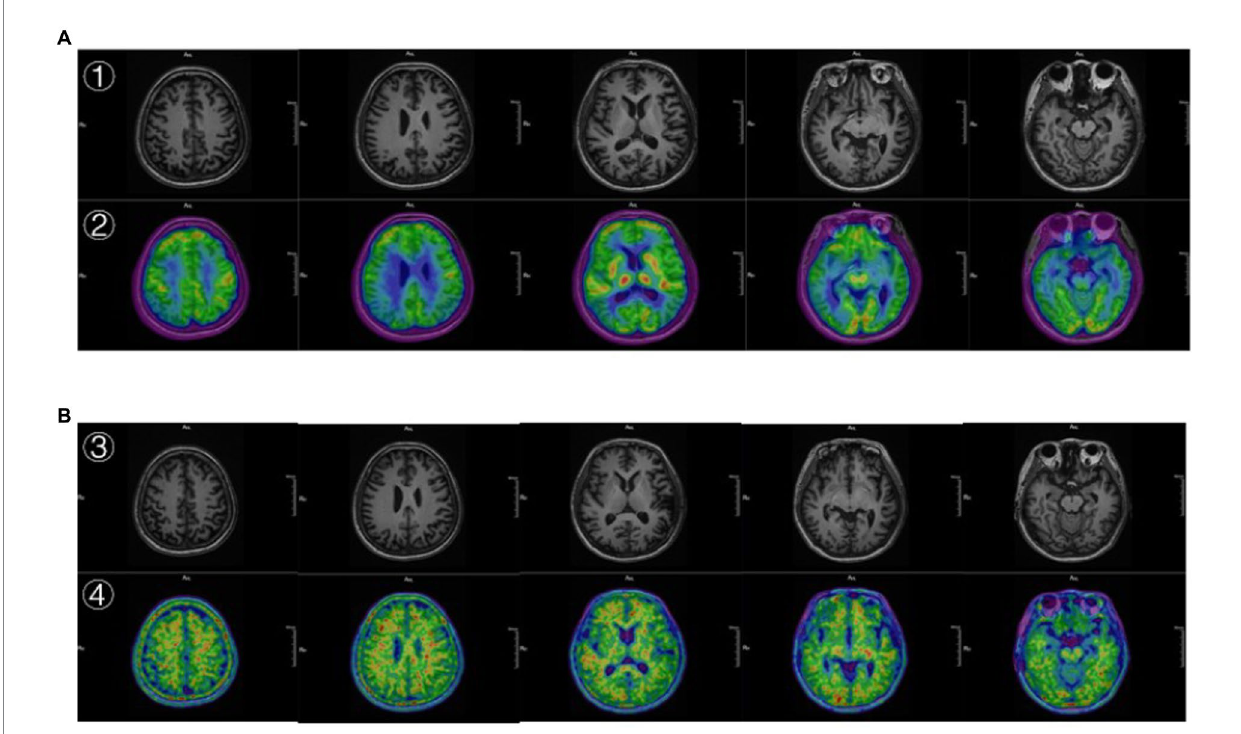
FIGURE 3 (A) ① The 3D T1 MRI. ② the image 18 F-FDG PET fused with MRI. ② Showed hypometabolism in the parietal, temporal, and posterior cingulate gyrus. (B) ③ The 3D T1 MRI. ④ The image 18 F-AV45 PET fused with MRI. ④ Showed significant cortical A β